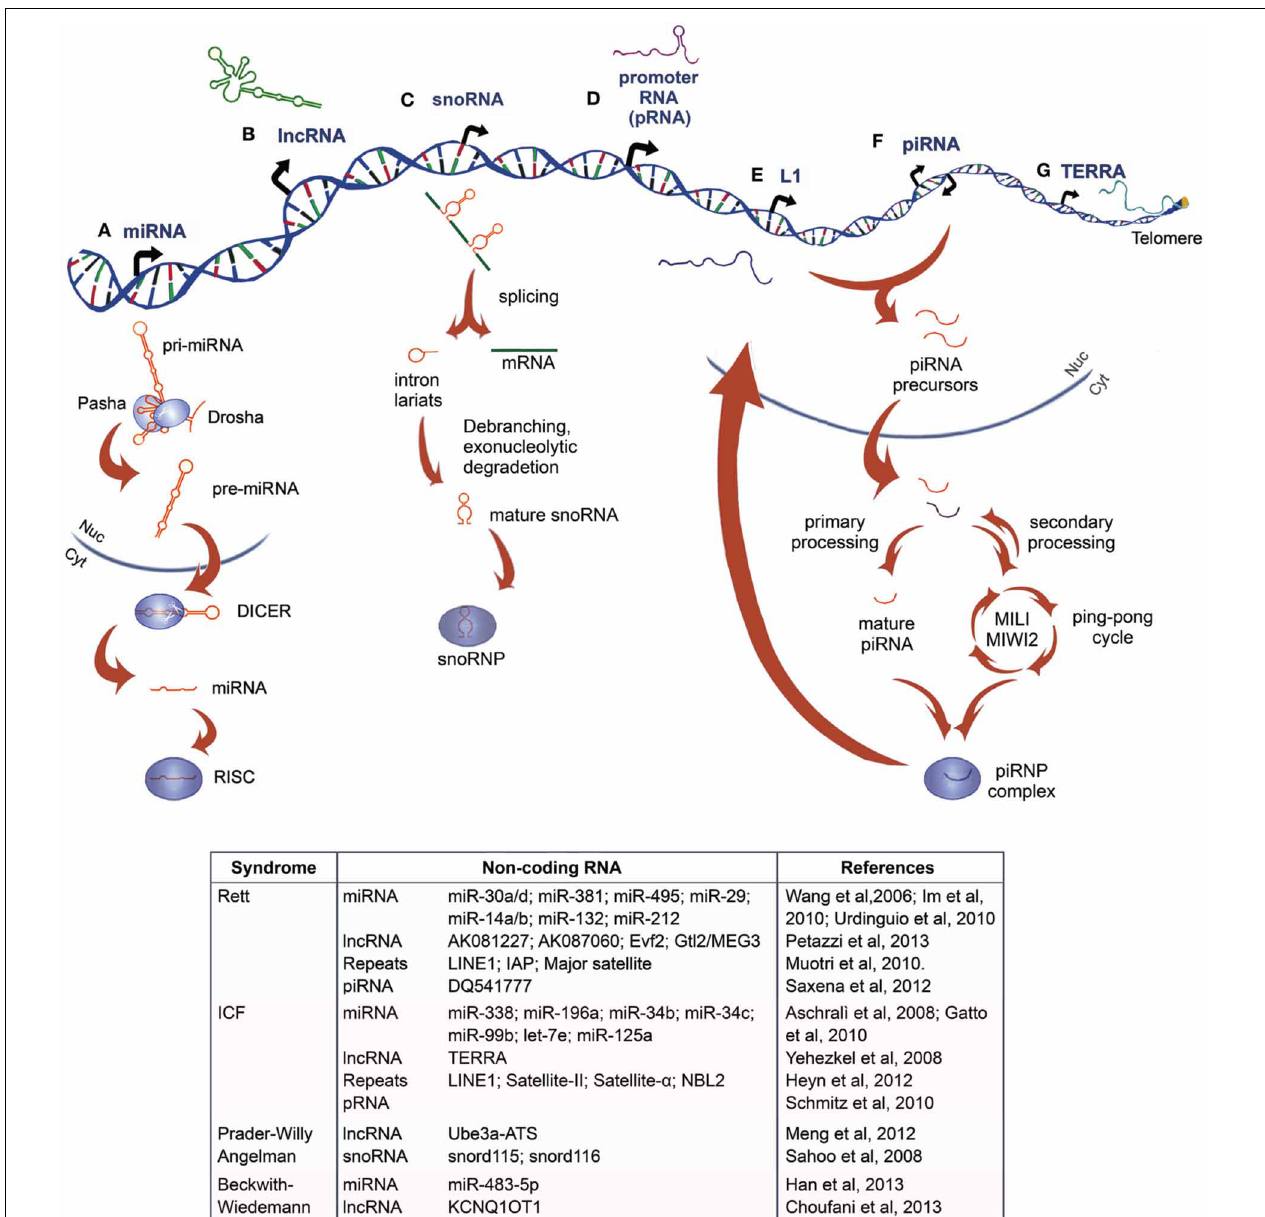
FIGURE 1 | Non-coding RNAs: biogenesis and their relation to chromatin disorders. (A) MicroRNAs originate as primary miRNA (pri-miRNAs) that are processed by the DROSHA/PASHA complex in the nucleus. The resulting precursor miRNAs (pre-miRNAs) are exported into the cytoplasm, where they are processed by DICER1 to form mature miRNAs, which interact with RNA-induced silencing complex (RISC), acquiring a post-transcriptional silencing activity (B) Long non-coding RNA are heterogeneous transcripts, often longer than 2kb, transcribed from intra- and intergenic regions by RNApol-II and, rarely, RNApol-III (C) Small nucleolar RNAs (snoRNAs) are codified primarily from introns. After the pre-mRNA generation, the transcript is spliced and the intron lariat is debranched and trimmed. The mature snoRNA interacts with ribonuclear proteins (RNPs), before being exported into the cytoplasm with a role in ribosomal RNA (rRNA) modification and processing, or retained into the nucleus, where it plays a role in alternative splicing and other unknown functions (D) In mouse, promoter-RNAs (pRNAs) are generated from intergenic regions located around 2kb upstream to the pre-rRNA